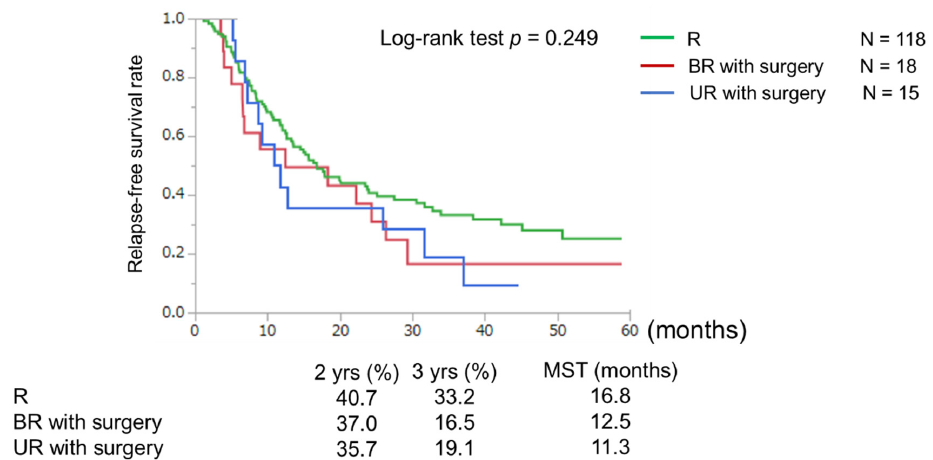
Figure 2. Overall survival classified by resectability in resection cases. The curve for the patient groups in which R—resectable, BR—borderline resectable with surgery, and UR—unresectable with surgery significantly differed from that for the BR and UR groups without surgery ( p < 0.0001).